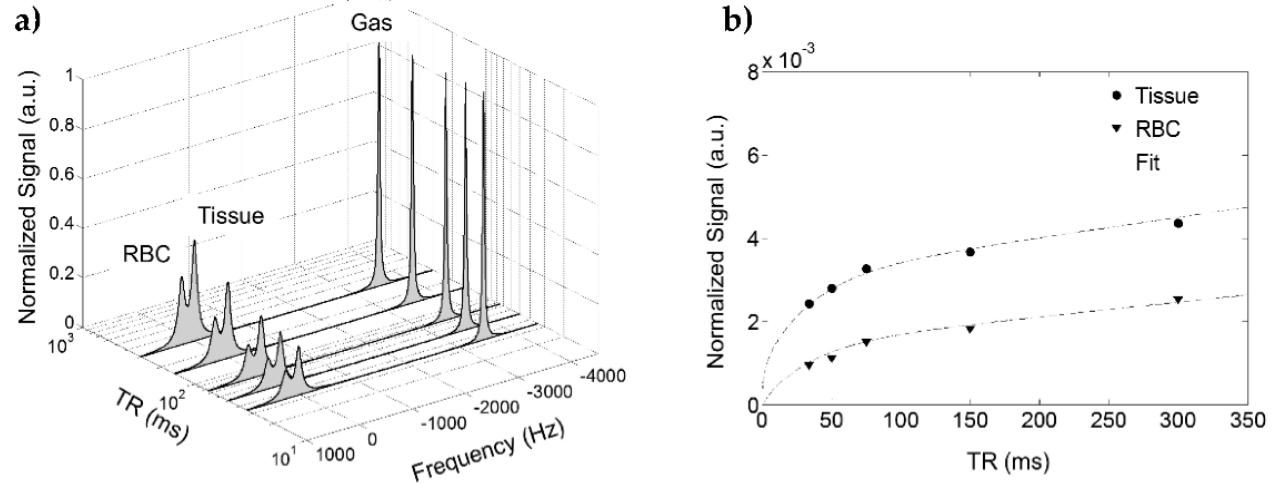
Figure 20. ( a ) Representative spectra acquired in a rat at various CSSR delay times and ( b ) the CSSR associated uptake curve. Reprinted with permission from Zanette, et al . ( Med Phys 2018, ref. [75]).